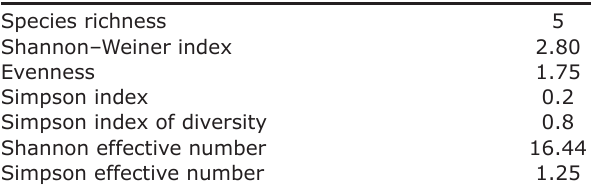
Table-2: Summary of the